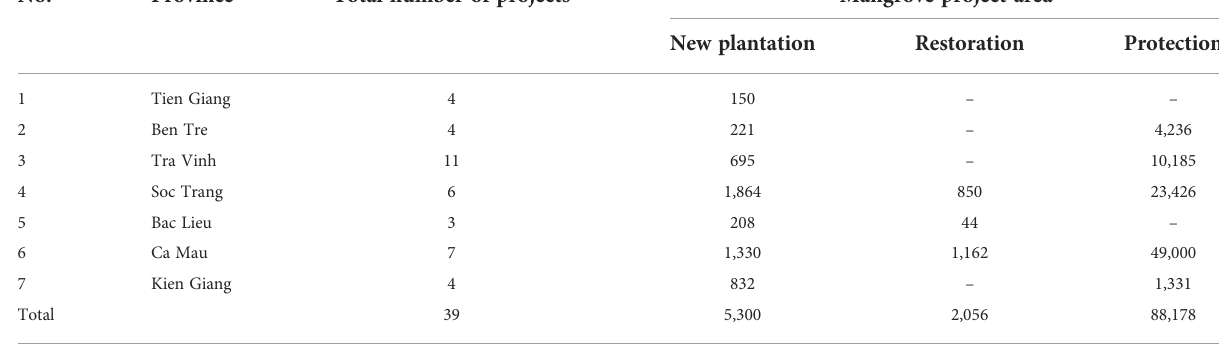
TABLE 2 Mangrove restoration projects in Mekong Delta during